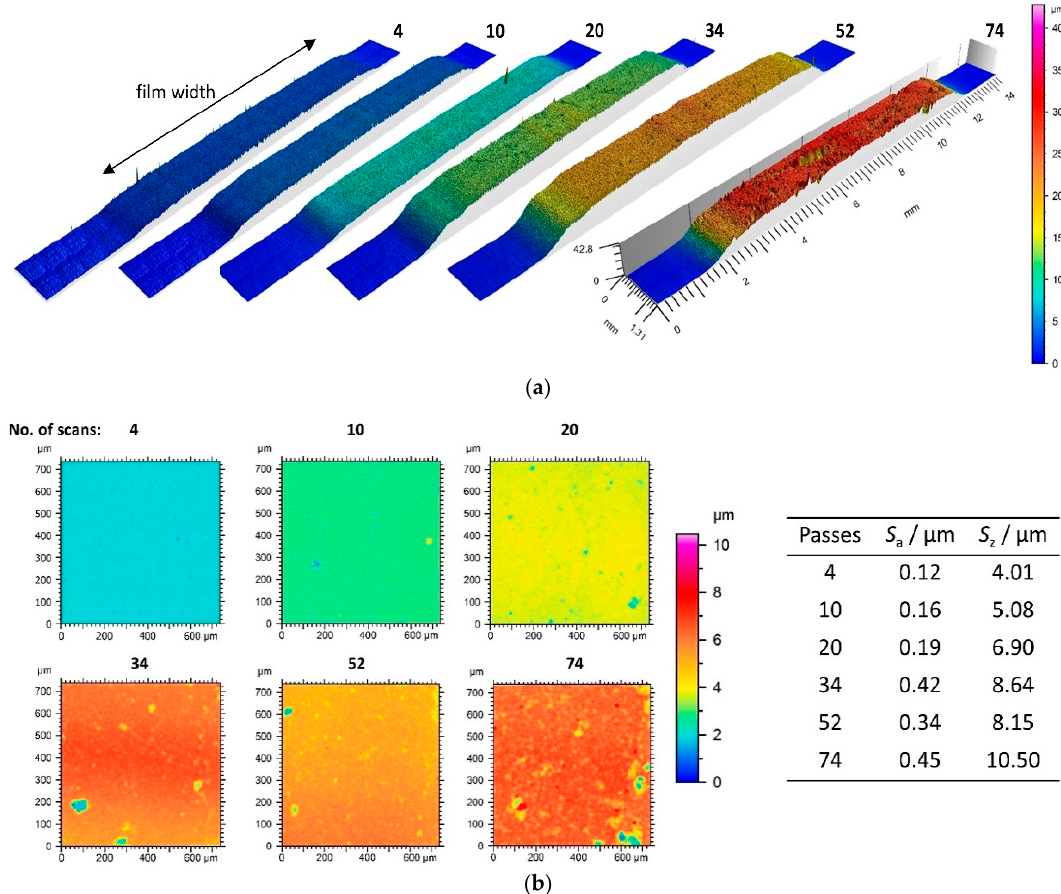
Figure 7. Pseudo-color areal surface profiles of MgB 2 films on glass substrate with ( a ) profiles parallel to nozzle width and ( b ) top-view on film surface and corresponding surface roughness values S a and S z . Numbers describe the number of passes for layer generation.